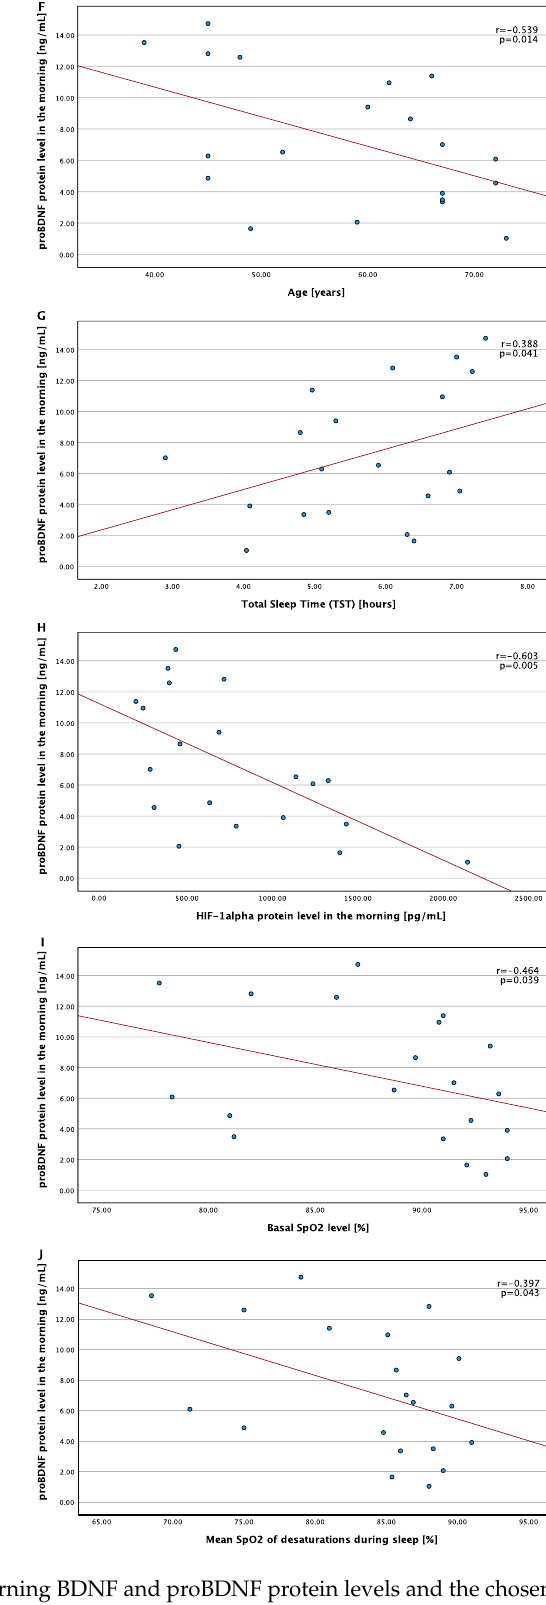
Figure 1. Correlation between morning BDNF and proBDNF protein levels and the chosen variables in the OSA group. Abbreviations: BDNF—brain-derived neurotrophic factor, HIF-1—hypoxia- inducible factor 1, OSA—obstructive sleep apnea, SpO 2 —oxygen saturation. ( A ) Correlation between the BDNF protein level in the morning and age; ( B ) correlation between the BDNF protein level in